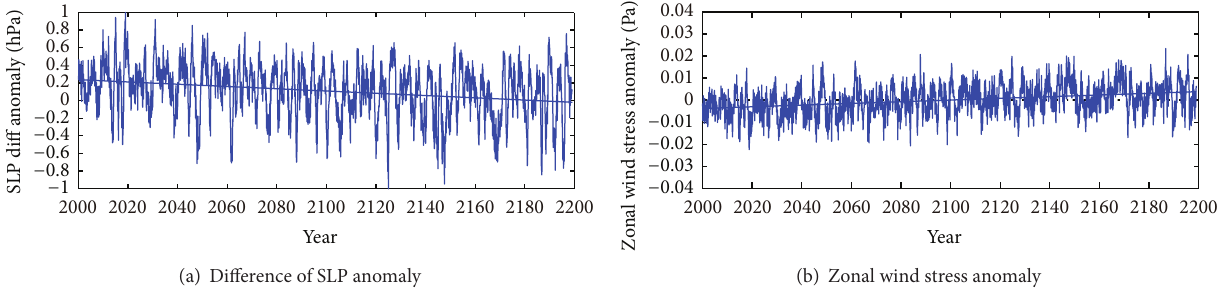
Figure 7: The evolution of the difference of the sea level pressure anomaly ( Δ SLP) between East Pacific (80 ∘ E-160 ∘ E, 5 ∘ S-5 ∘ N) and West Pacific (160 ∘ W-80 ∘ W, 5 ∘ S-5 ∘ N) and zonal wind stress anomaly in equatorial Pacific (120 ∘ E-70 ∘ W, 5 ∘ S-5 ∘ N) since the 20th century from IPCC-AR4 data.